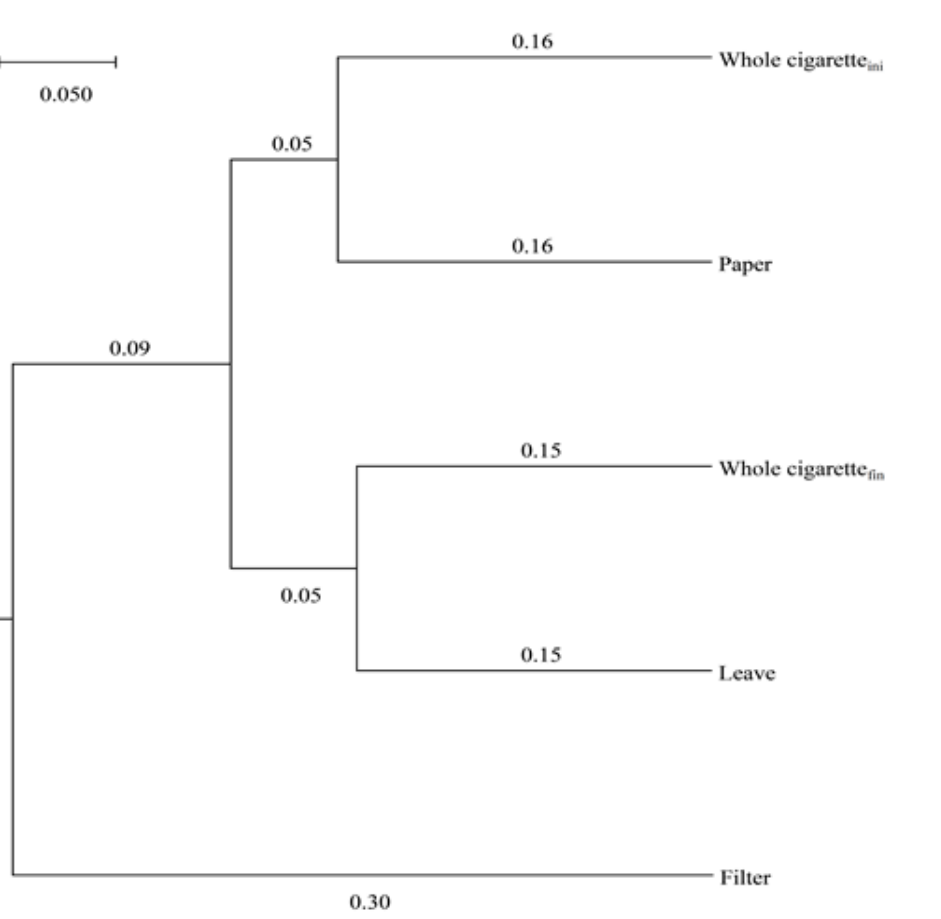
Figure 3. UPGMA clustering of bacterial microbes fed intact cigarettes or individual components for anaerobic digestion.